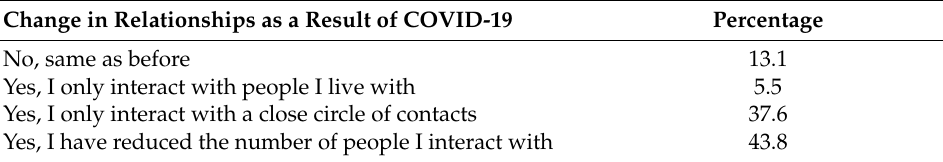
Table 3. Distribution (in percentages) of the change in social relationships.